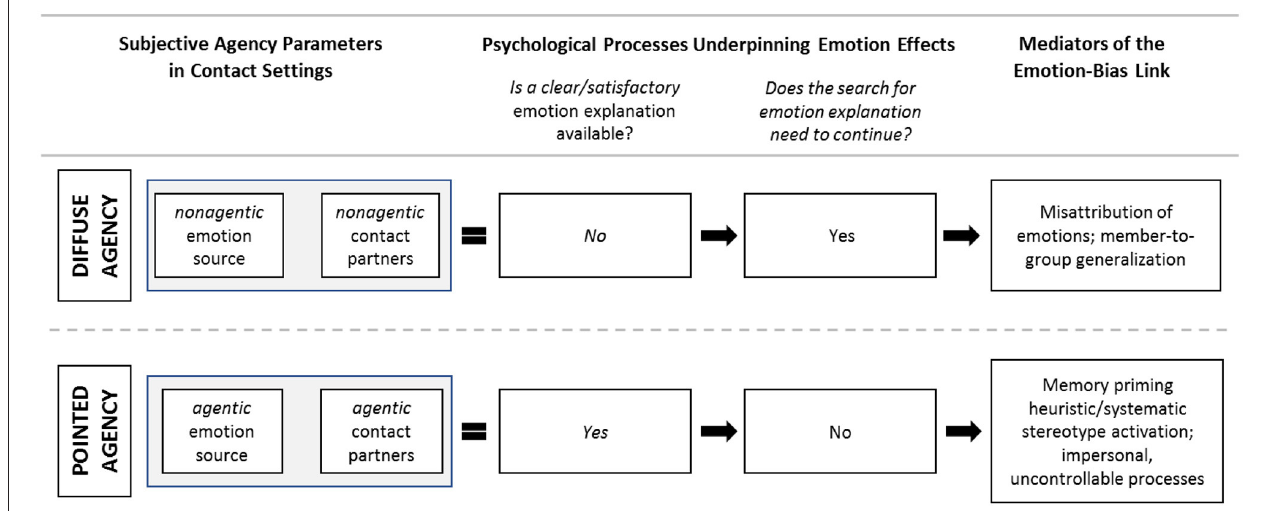
FIGURE 3 | Expectations derived from contemporary emotion appraisal theory and emotion research that variations in the perceived agency of emotion source and contact partners together will impact the interpretation of emotions during contact, affect the processes underpinning judgment construction and thus shape the mediators of the emotion-bias